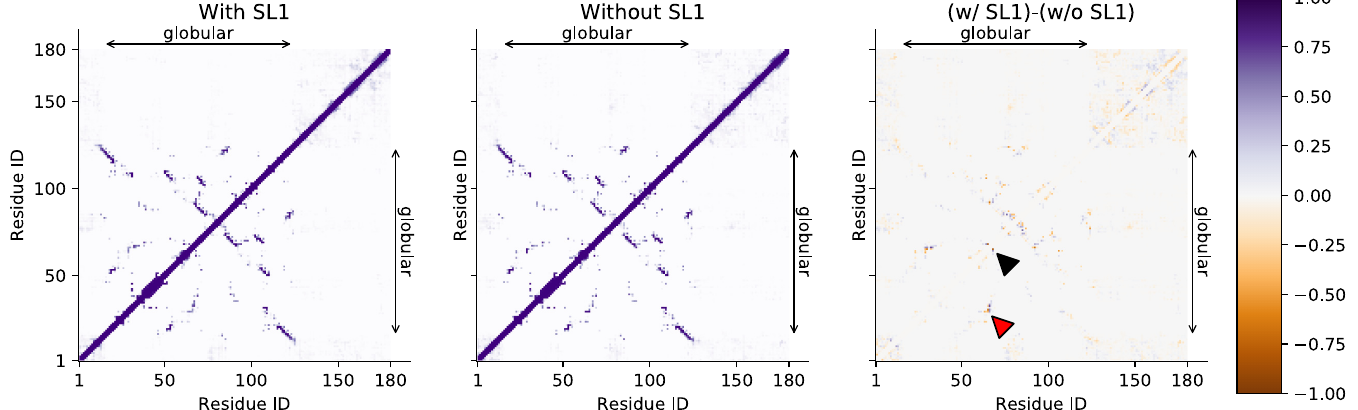
Fig 6. Interactions within nsp1. Contact probabilities between nsp1 residues were color-coded. Regions corresponding to residues 14–125, which are visible in the X- ray crystallographic structure (PDB ID 2HSX), are shown as arrows on the right and the top of each image. (Left, middle) the probabilities for nsp1 with and without SL1. (Right) the difference of the two (with SL1 minus without SL1). Residue pairs referenced in the main text are annotated by black and red wedges (pointing residue pairs 65–68 and 30–65,